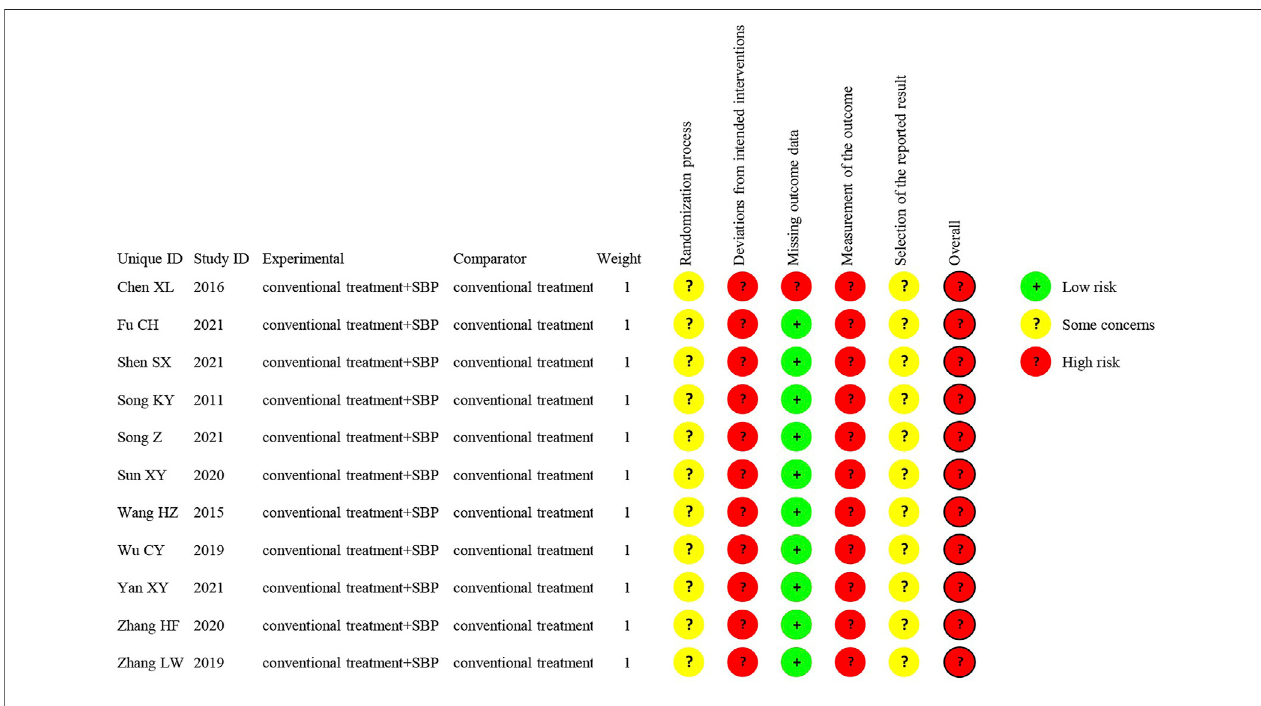
FIGURE 2 | Risk of bias graph.